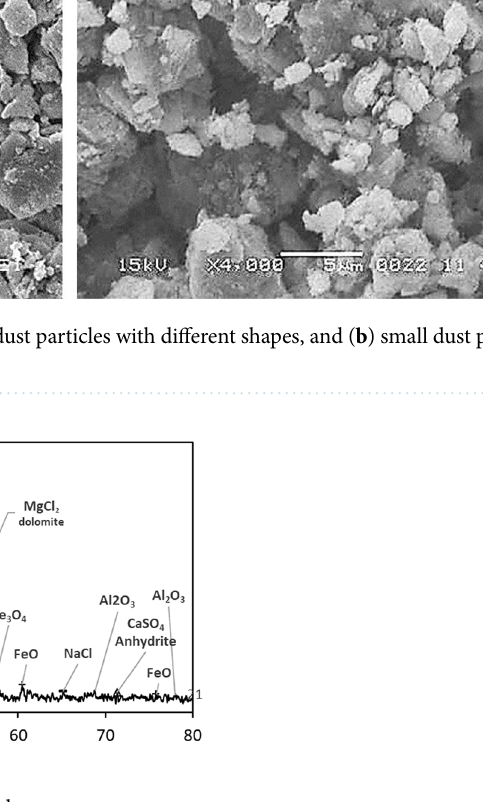
Figure 3. X-ray data for collected untreated